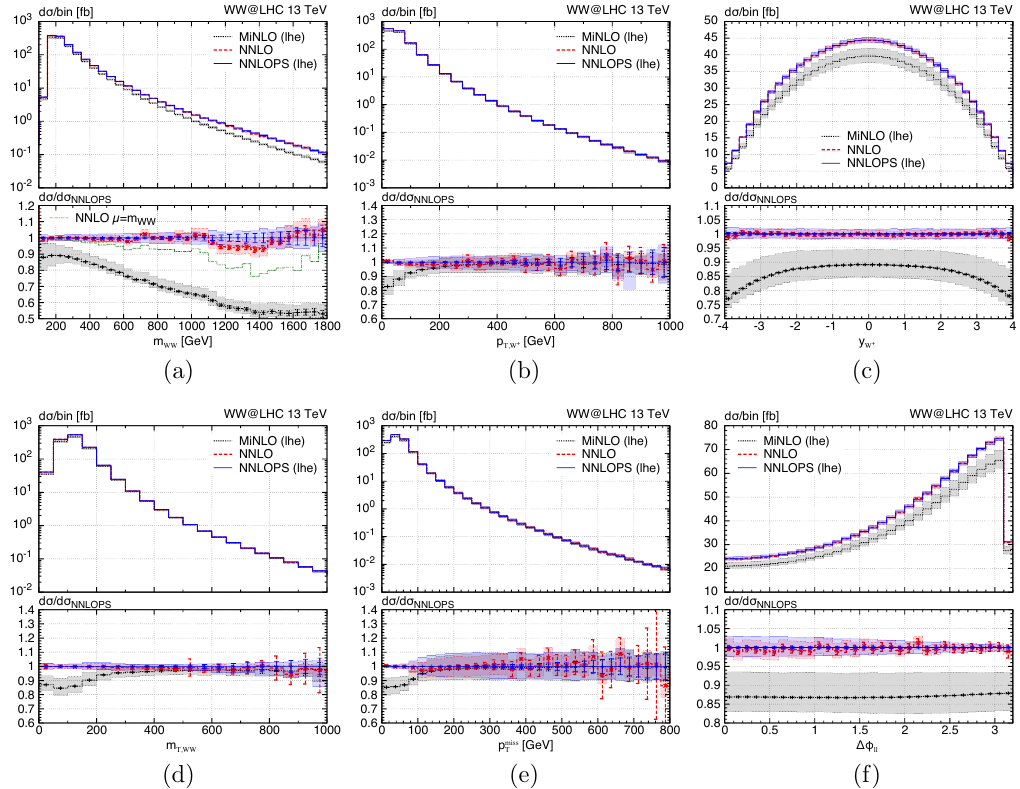
Figure 5 . Same as (cid:12)gure 2, but for observables which have not been used in eq. (2.7) to de(cid:12)ne a basis of the Born-level phase space: (a) invariant mass of the W + W (cid:0) pair m , (b) transverse WW momentum p and (c) rapidity y of W + , (d) transverse mass of the W + W (cid:0) pair m T;WW T;W + W + de(cid:12)ned eq. (2.17), (e) missing transverse momentum p miss and (f) lepton separation (cid:1) (cid:30) ‘‘ T